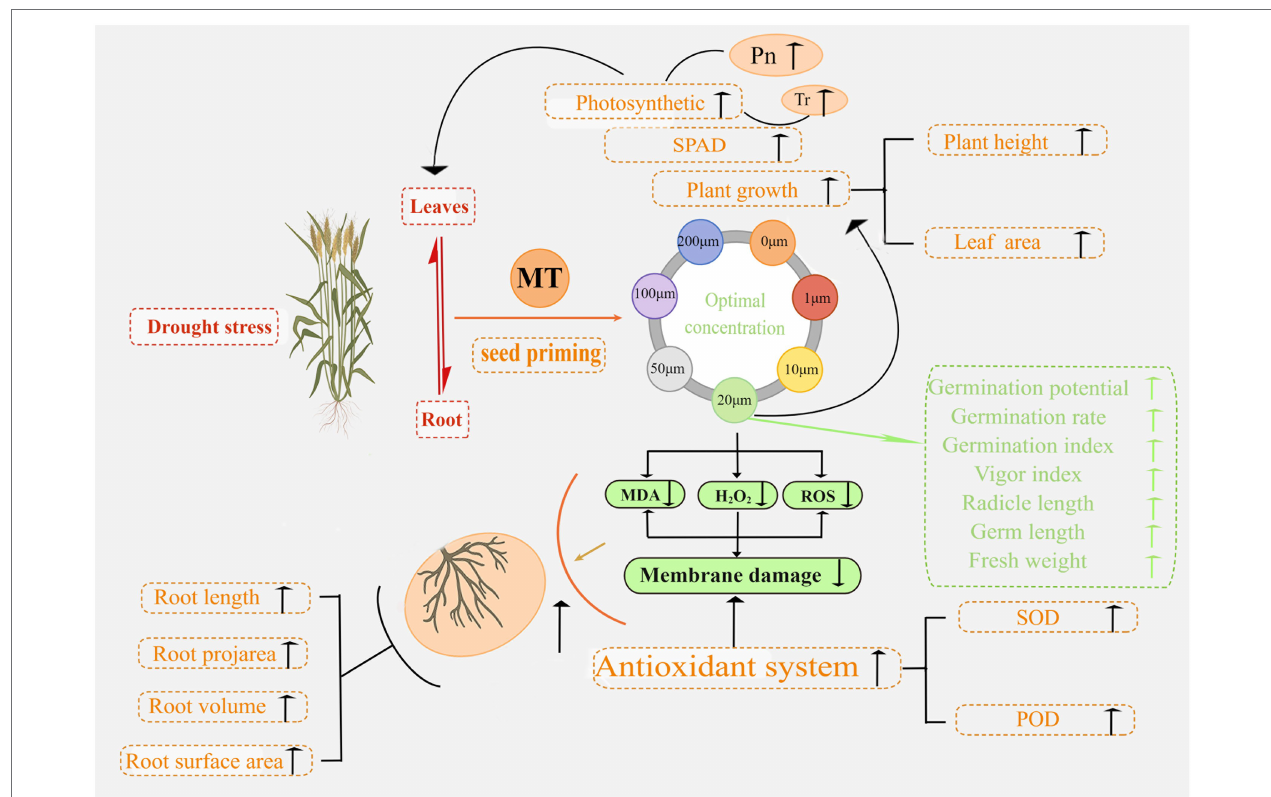
FIGURE 15 | Proposed mechanism of action underlying the enhancement of seed germination and seedling growth by melatonin priming under drought